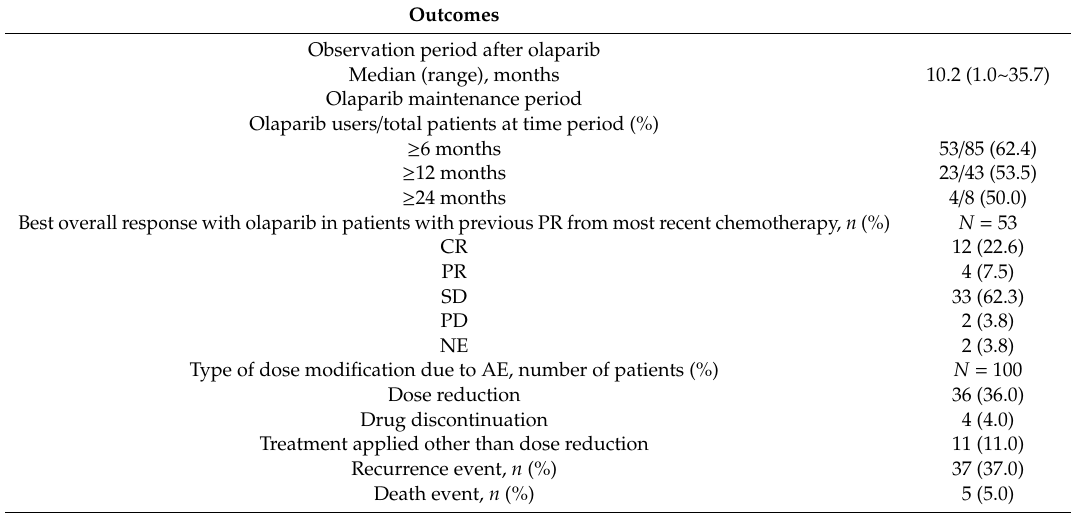
Table 2. Outcomes of olaparib maintenance in high-grade serous recurrent ovarian cancer patients with BRCA1 / 2 mutation.